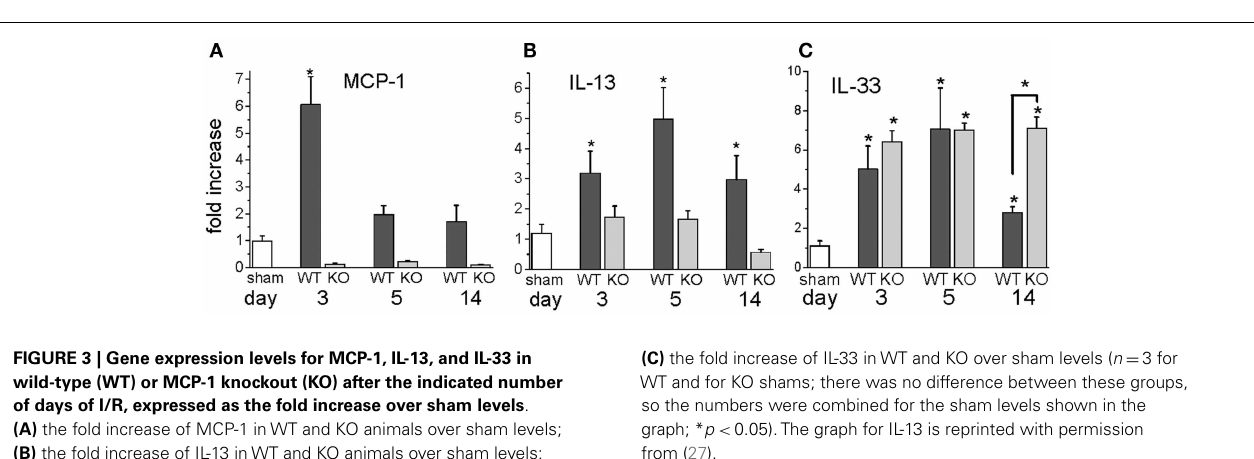
FIGURE 3 | Gene expression levels for MCP-1, IL-13, and IL-33 in wild-type (WT) or MCP-1 knockout (KO) after the indicated number of days of I/R, expressed as the fold increase over sham levels . (A) the fold increase of MCP-1 inWT and KO animals over sham levels; (B) the fold increase of IL-13 inWT and KO animals over sham levels;